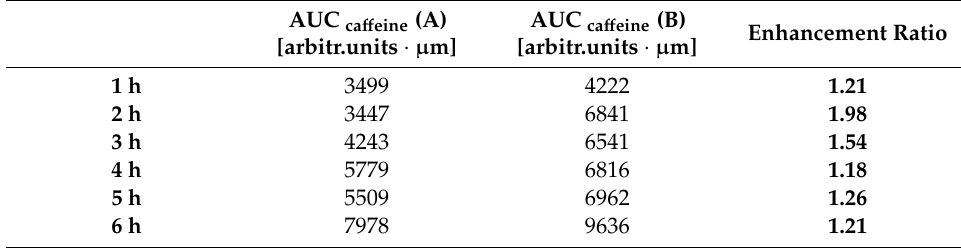
Table 1. cumulative ca ff eine signal in the skin for every measurement point for the 2% ca ff eine solution ( A ) and the 2% ca ff eine solution + 5% pentanediol ( B ), and the calculated enhancement ratio. AUC ca ff eine (A) [arbitr.units · µ